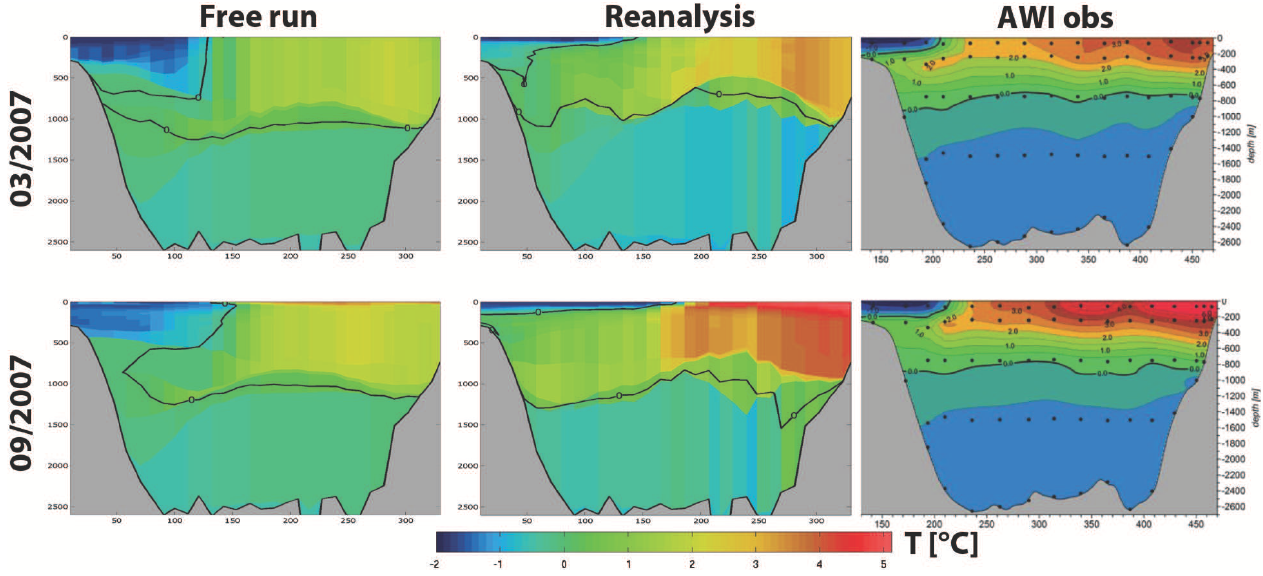
Fig. 17. Temperature in the Fram Strait section from the free run, reanalysis and observations.